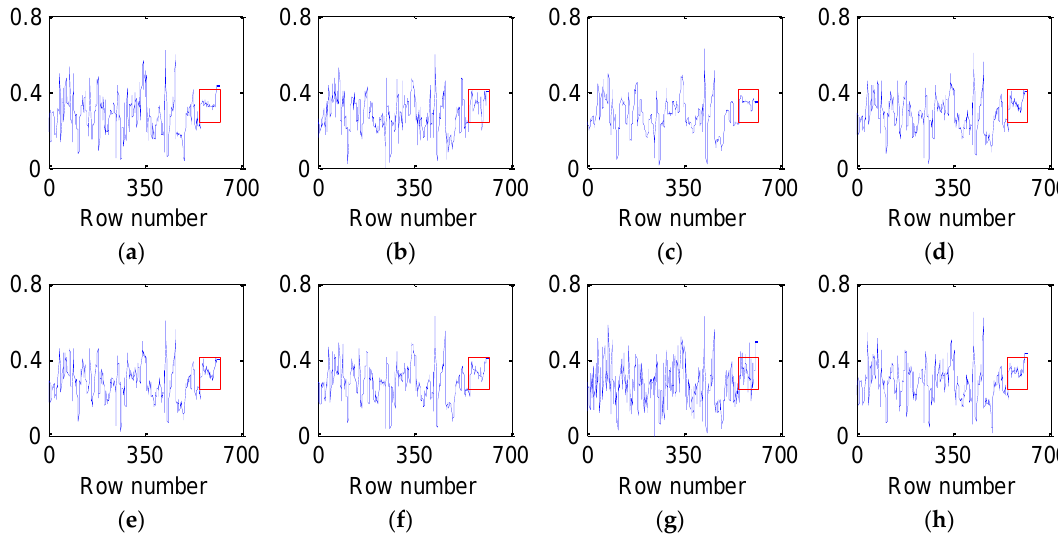
Figure 11. Vertical profiles of band 90 at pixel (399, 290) before and after denoising: ( a ) clean HSI; ( b ) KSVD; ( c ) BM3D; ( d ) ANLM3D; ( e ) BM4D; ( f ) LRMR; ( g ) DDL3+FT; ( h ) Our method.